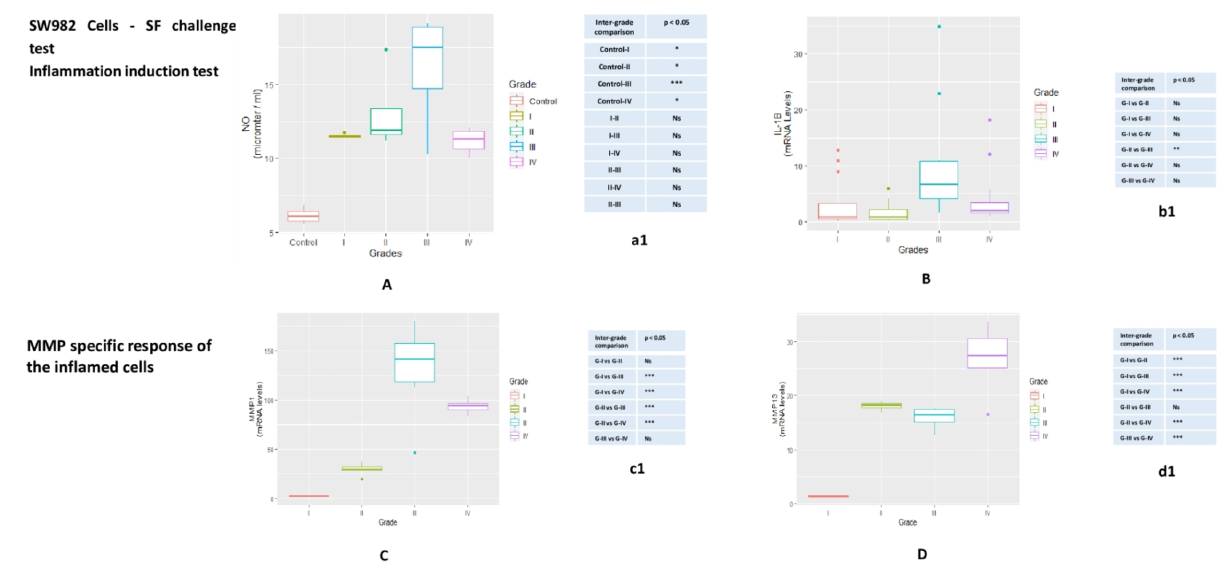
Figure 3. SF challenge test on SW982 cells—this test was performed to assess MMPs modulation in inflamed SW982. The cells were treated with 5% SFs (of culture media) of progressive OA grades for 72 hrs to induce inflammation. Inflammation induction test—( A ) NO release after 72 hrs of SF treatment on SW982 cells ( B ) mRNA levels of IL- β estimated in SW982 cell after 72 hrs SF treatment. This set of experiments was performed as a confirmation test for successful inflammation induction in the cells after the treatment with SFs from progressive OA patients. For SW982 cells, statistical difference in NO and IL-1 β levels observed during inter-grade comparison and compared to the control is showed in tables a1 and b1 respectively. MMP specific response of the inflamed cells—( C ) MMP-1: a grade-wise up-regulation was noted, where the highest increase in the expression level was found in the cells, which were treated with SFs from KL grade-III; ( D ) MMP-13: a grade-wise increase in the expression was noted with the highest expression in the cells treated with SFs from KL grade-IV. The difference revealed during inter-grade comparison for MMP-1, MMP-13 on SW982 cells is showed in the tables—c1 and d1, respectively. * p < 0.05, ** p < 0.01, *** p < 0.001. Ns =